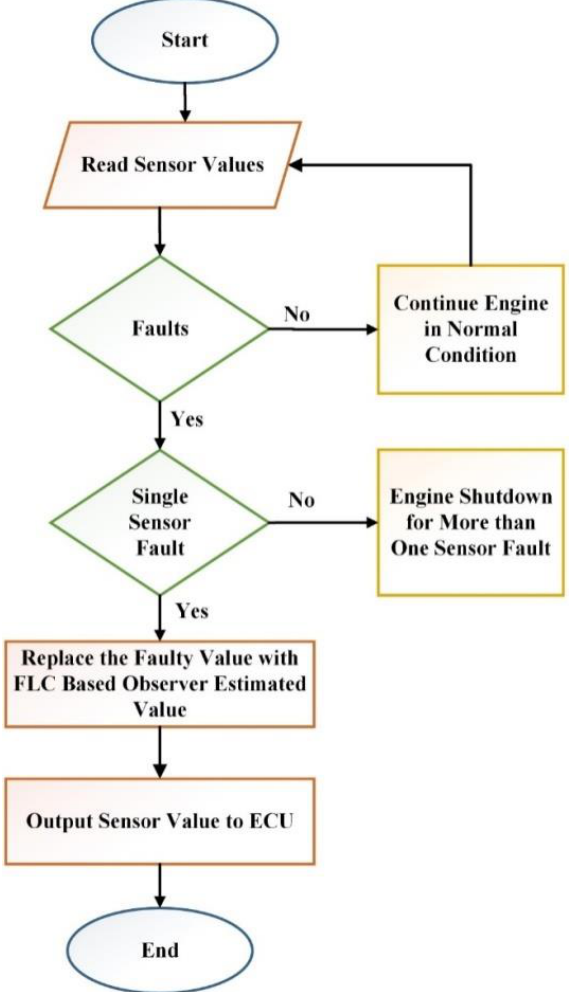
Figure 5. Flowchart of proposed AFTCS.